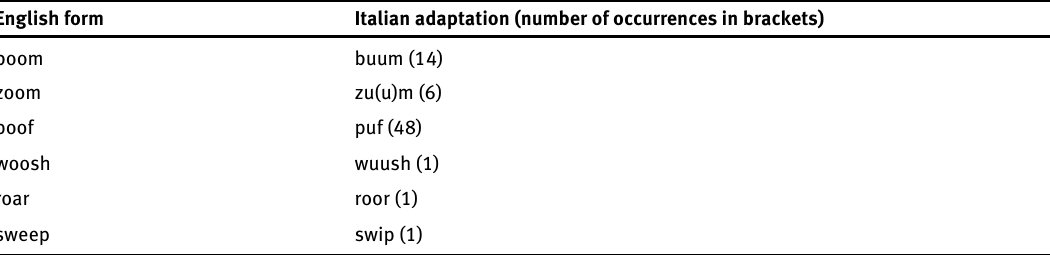
Table 7. Cases of vocalic substitution. English